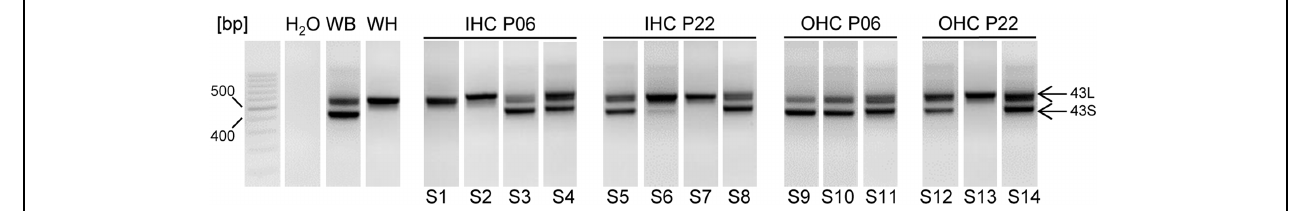
FIGURE 5 | Cav1.3 α 1 transcripts containing exons 43 S and 43 L in mouse IHCs and OHCs, at P6 and P22 using nested PCR. Fragments containing 43S (403 bp) or 43L (557 bp) were amplified using nested PCR (see Materials and Methods) with primers specific for exon 42 (forward) and 45 (reverse) of mouse Cav1.3. S1–S14 represent samples from independent preparations. For each cell type and developmental stage at least three independent experiments were performed. Whole brain (WB) and heart (WH) served as positive controls,